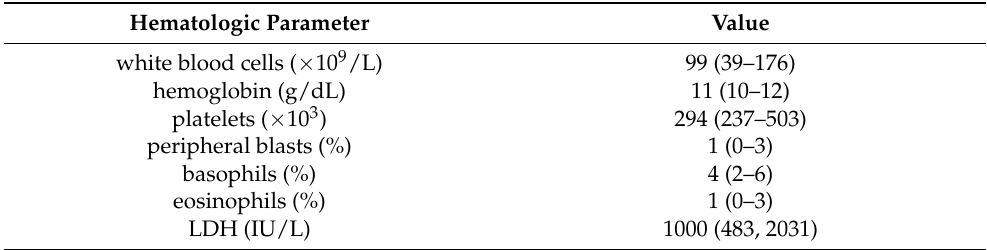
Table 4. Hematologic parameters of the patients included in the study.